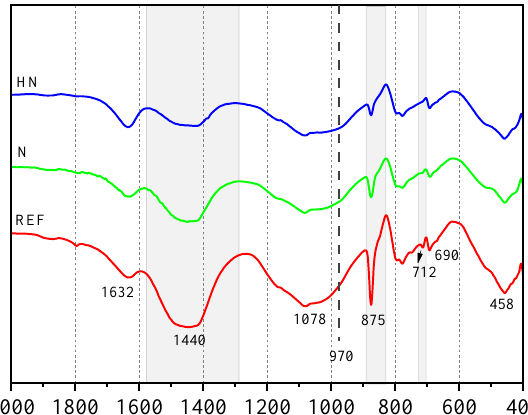
Figure 6. FTIR patterns of different samples after carbonation. The dashed line in Figure 6 locates in a position at 970 cm − 1 , which represents a band corresponding to the Si–O stretching vibration in C–S–H. At a Ca/Si of ≈ 1.7, the frequency of this band will increase along with the decalcification of C–S–H [27]. In Figure 6, the bands near 970 cm − 1 in all the three patterns shift to a higher frequency area at 1078 cm − 1 , while the position at 1080 cm − 1 corresponds to amorphous silica gel, which is the final product of the decalcified reaction of C–S–H. This observation indicates the occurrence of different degrees of C–S–H decalcification: the stronger band at 1078 cm − 1 reflects a larger content of amorphous silica gel and indicates a higher degree of decalcification. Taken